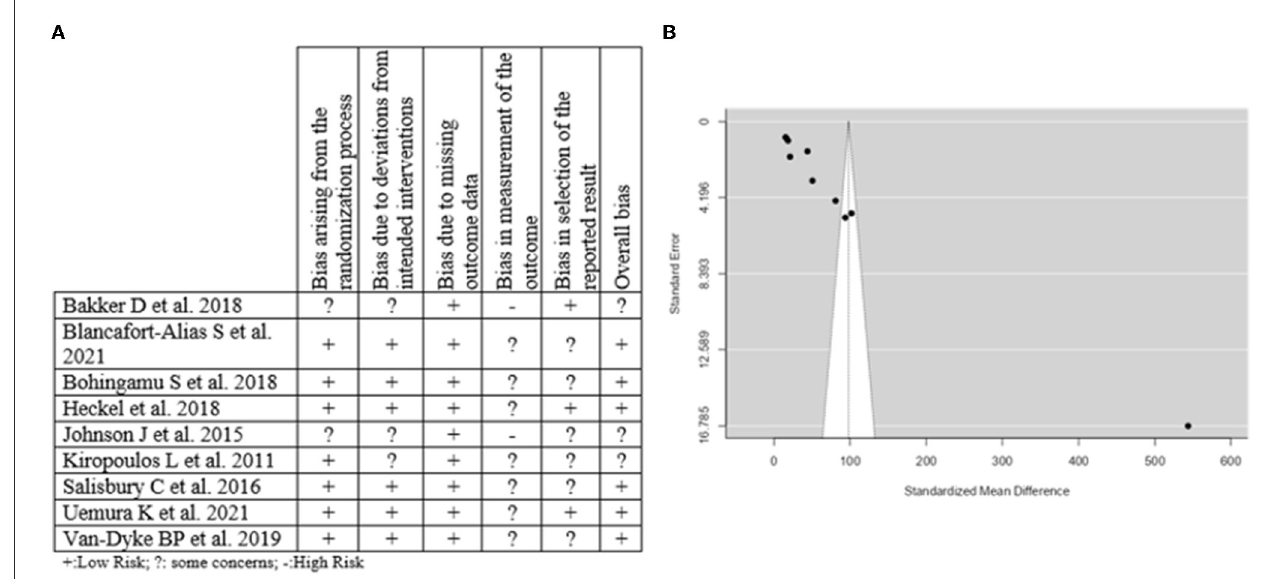
FIGURE4 Risk of bias assessment and publication bias of the included studies. (A) Risk of bias assessment. (B) Funnel